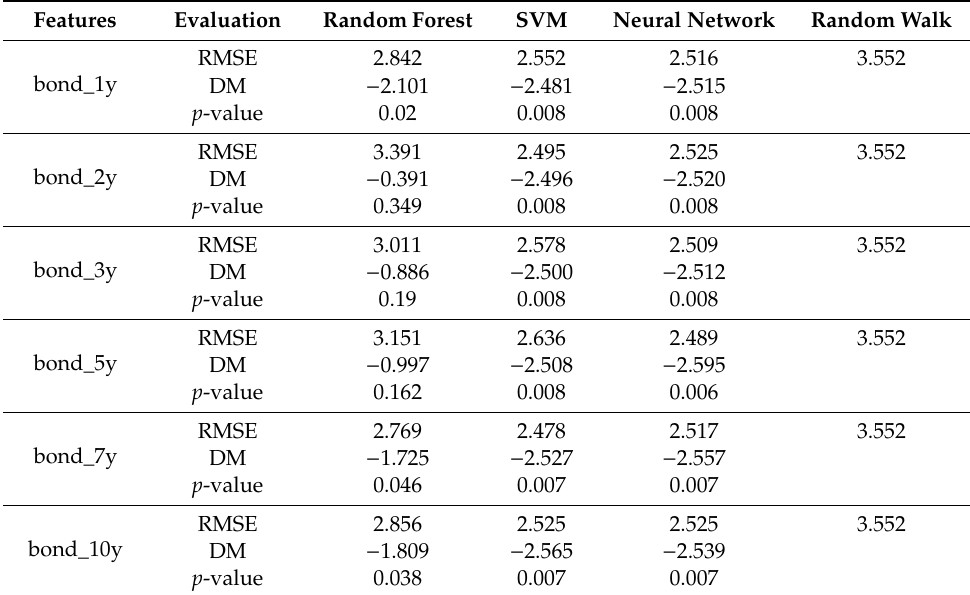
Table 2. Results for the uncovered interest rate parity (UIRP) model.